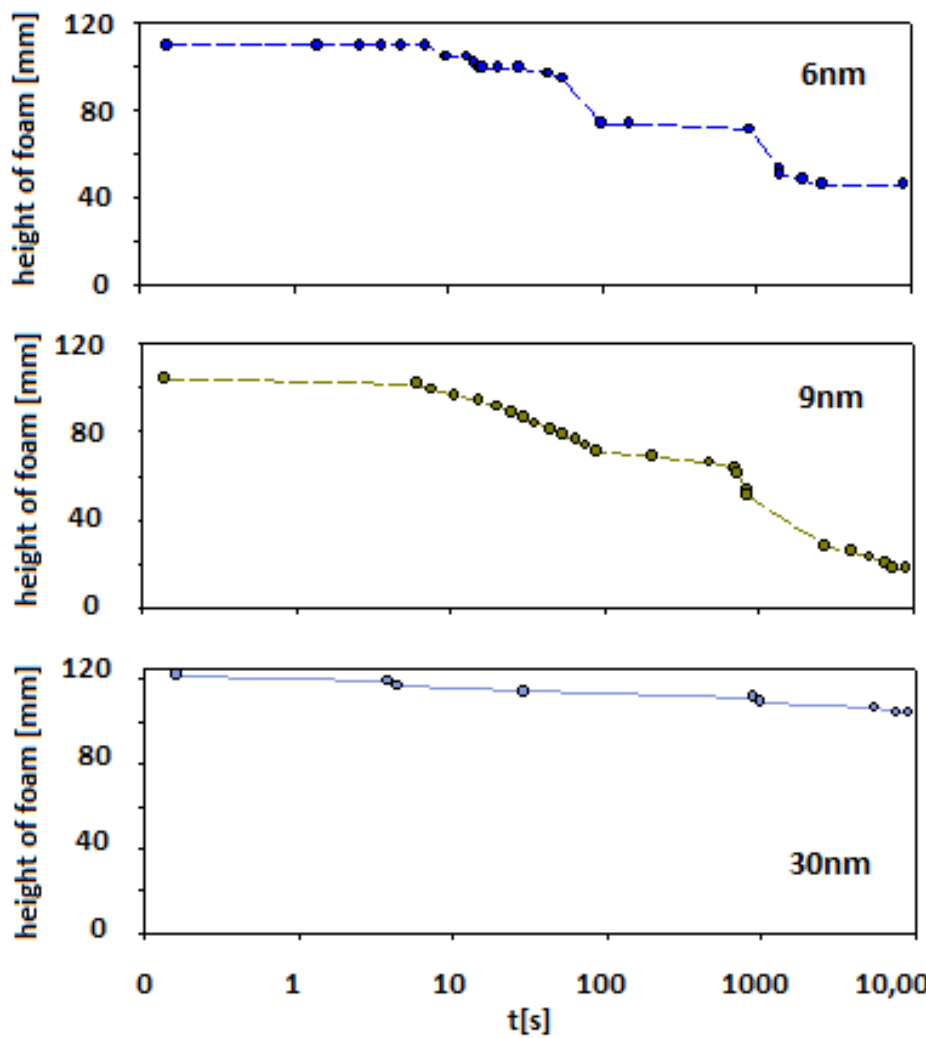
Figure 4. The foam ageing in chitosan—LAE—Levasil ® mixtures (depending on the type of Levasil ® used).